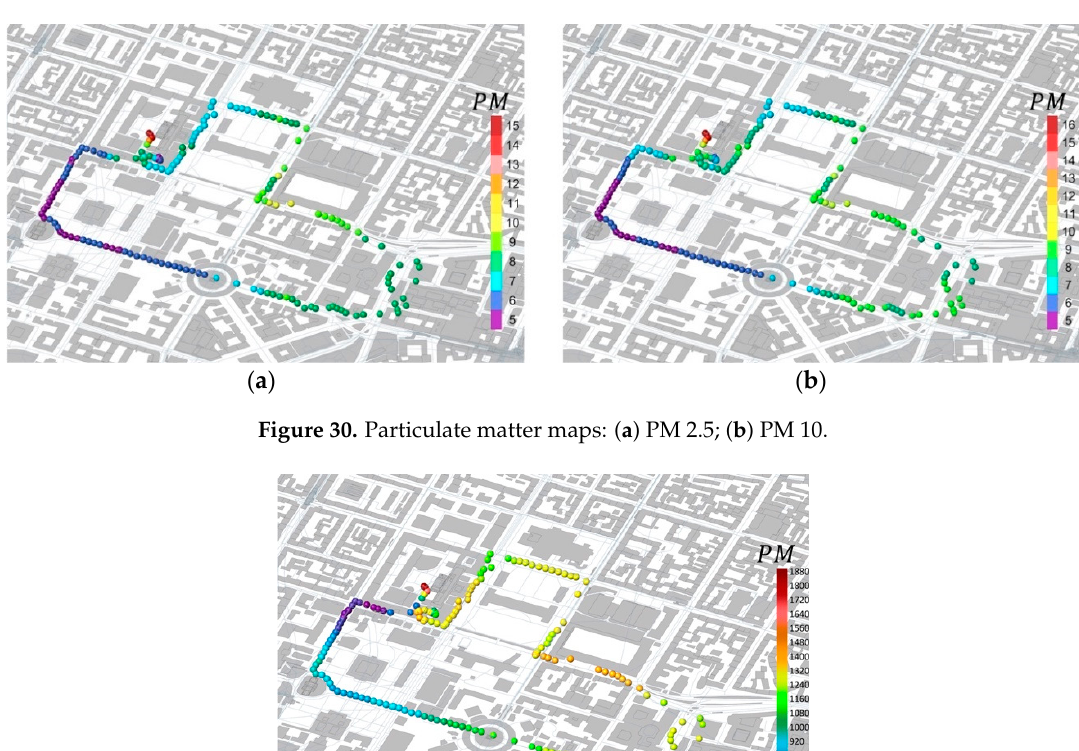
Figure 29. ( a ) Mean radiant temperature (°C); ( b ) universal thermal climate index maps (°C).